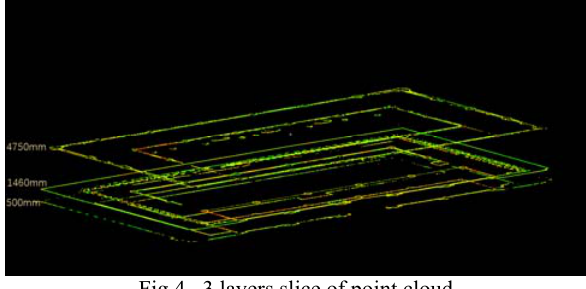
Fig.4 3 layers slice of point cloud